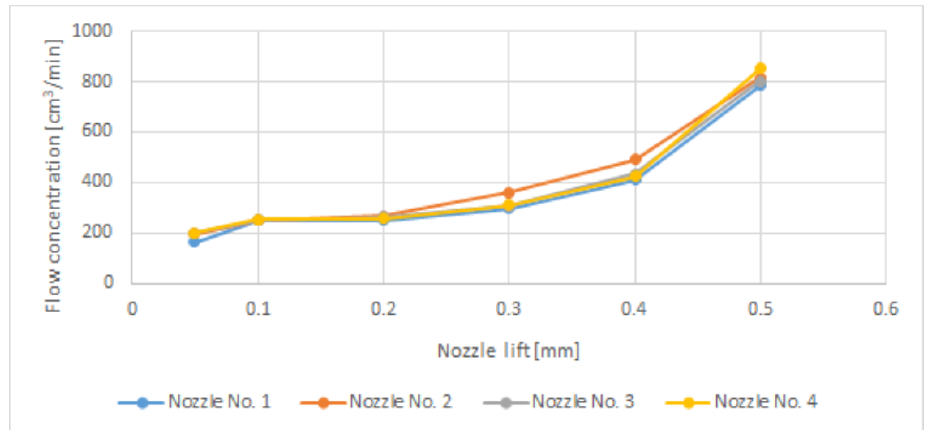
Figure 11. The flow before the test for